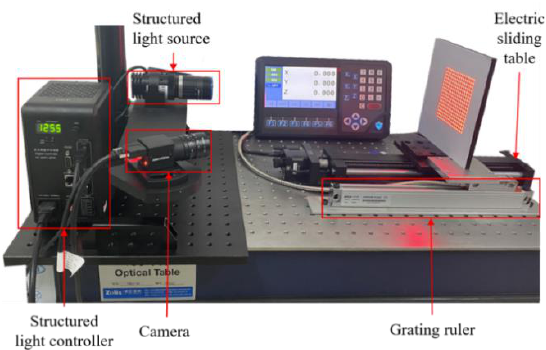
Figure 9. The experimental setup.